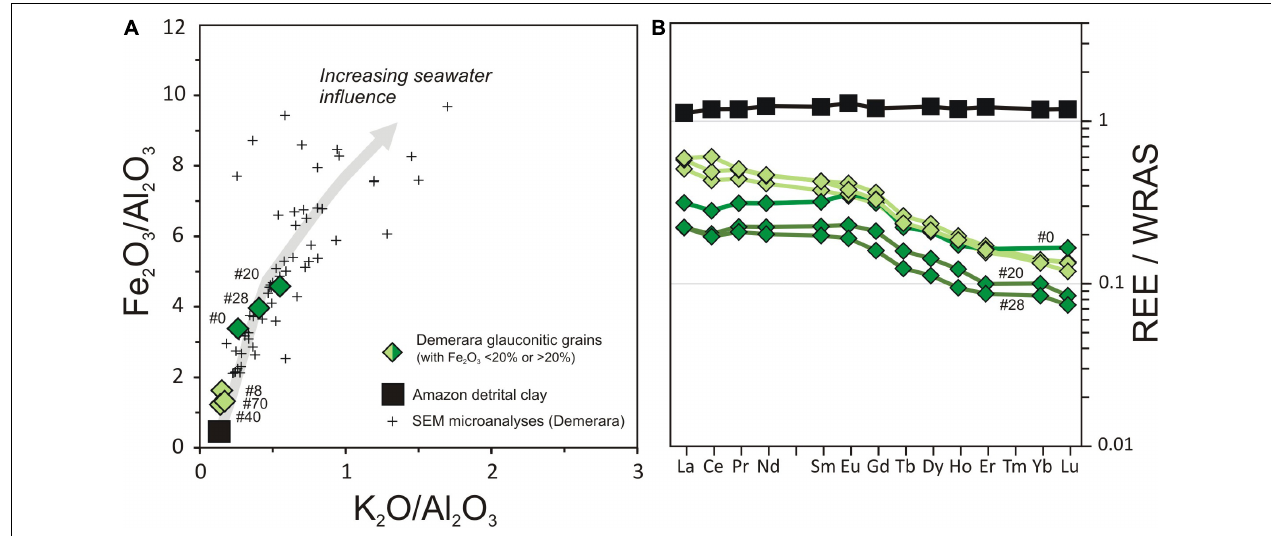
FIGURE 7 | (A) Relationship between Fe 2 O 3 /Al 2 O 3 and K 2 O/Al 2 O 3 for bulk glauconitic grains from core IG-KSF-11 (diamonds), compared to microscale results obtained by SEM/EDS analyses (crosses). (B) Shale-normalised REE patterns of bulk glauconitic grains. WRAS refers to World River Average Silt (Bayon et al., 2015). Note that # refers the sample depth (cm). Values for Amazon detrital clay are from Bayon et al. (2015).